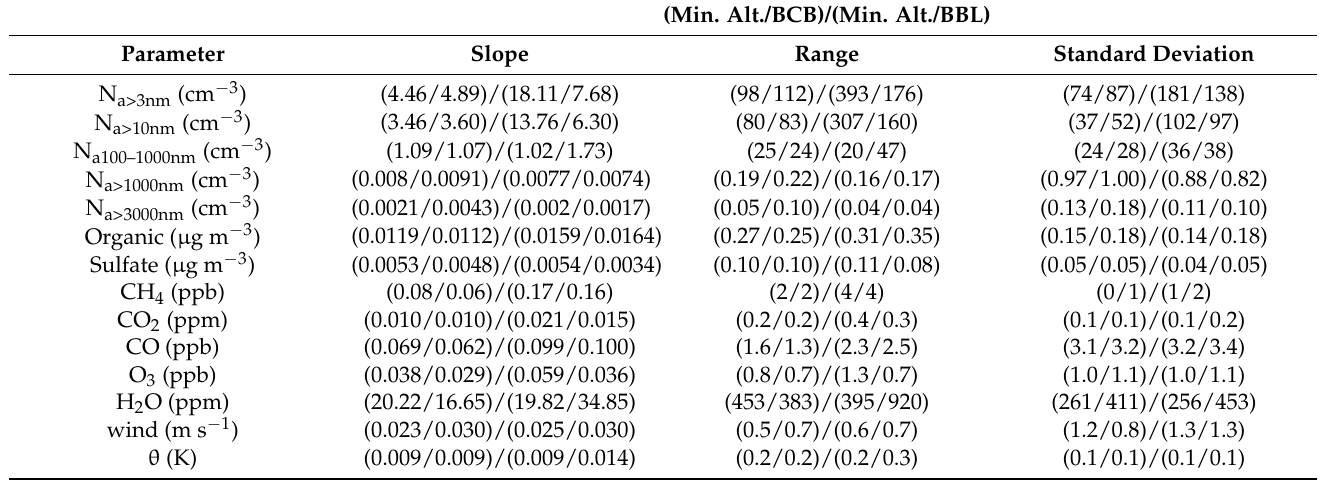
Table 5. Same as Table 4 but for ACTIVATE 2020